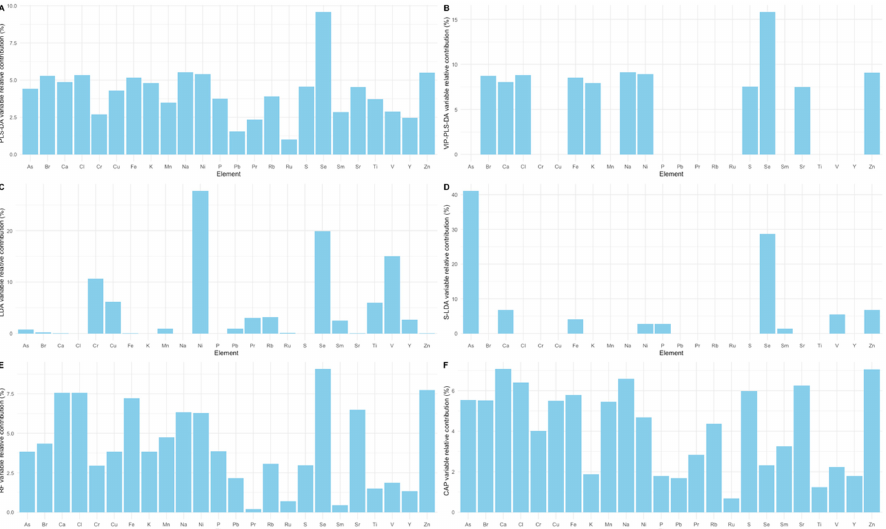
Figure 5. Element variable relative contribution in each of the chemometric models tested: Partial least-squares discriminant analysis (PLS-DA, A ), variable importance in projection partial least- squares discriminant analysis (VIP-PLS-DA, B ), linear discriminant analysis (LDA, C ), stepwise lin- ear discriminant analysis (S-LDA, D ), random forests (RF, E ) and canonical analysis of principal coordinates (CAP, F ).